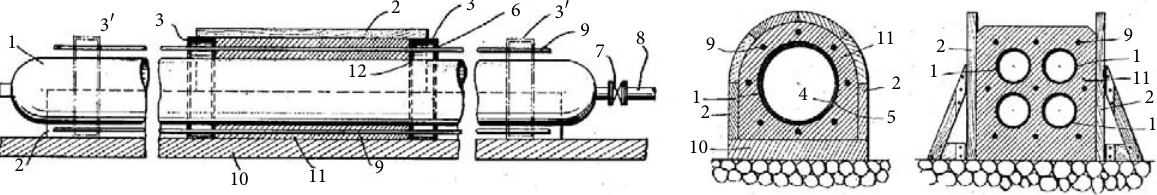
Figure 1: Construction method for pipes proposed by Nose [6].